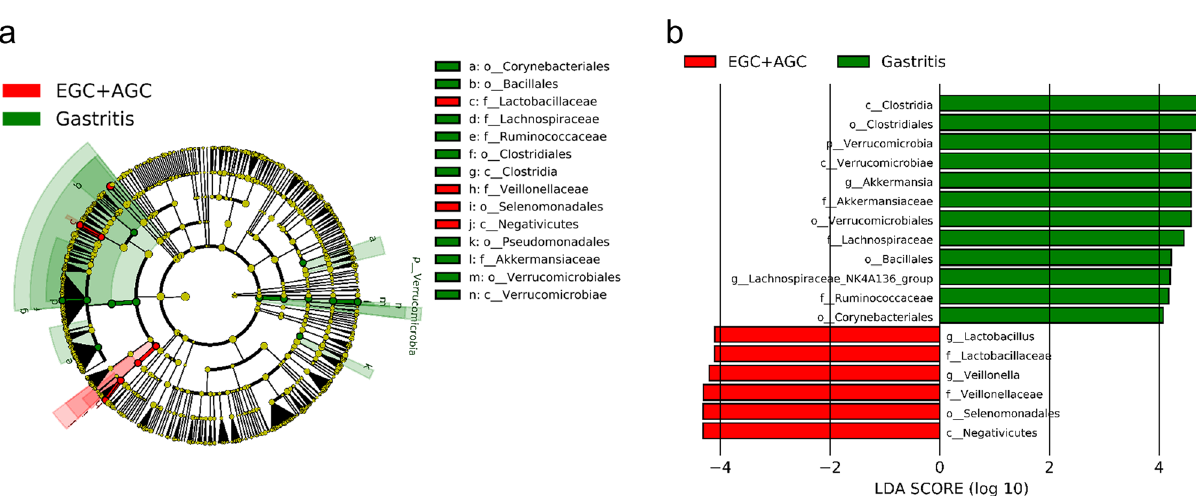
Figure 4. Identification of microbial biomarkers for gastric cancer with LEfSe. ( a ) Cladogram showing differentially abundant taxa of the gastric microbiome between the cancer group and gastritis group. ( b ) Association of specific microbial taxa with the cancer group and gastritis group was investigated with linear discriminant analysis (LDA) effect size (LEfSe), using a LDA cut-off score of 4.0 or greater. Taxa enriched in the cancer group are indicated in red, and taxa enriched in gastritis group are indicated in